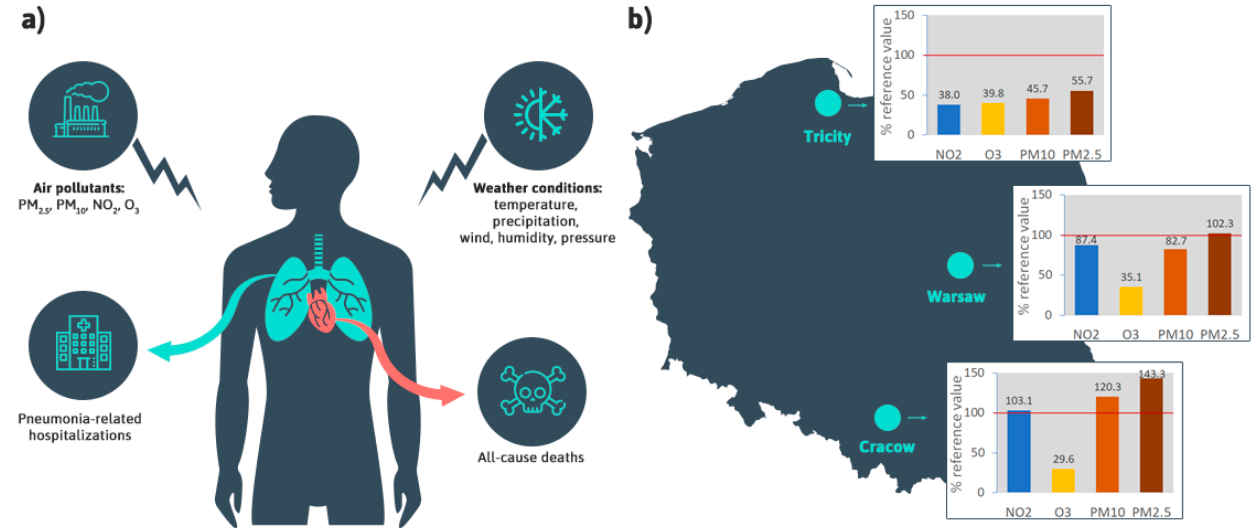
Figure 1. ( a ) The cause and effect relationship between the exposure to air pollution and associated weather conditions and health outcomes, including pneumonia-related hospitalizations and all- cause deaths; ( b ) geographical location of agglomerations: Tricity, Warsaw, and Cracow with mean concentrations of air pollutants in 2011–2018, expressed as a percentage of the reference values (cal- endar year limit values of 40 μ g/m 3 for PM 10 and NO 2 , 25 μ g/m 3 for PM 2.5 , and maximum daily eight- hour mean target value of 120 μ g/m 3 for O 3 were applied according to air quality standards stated in the EU Ambient Air Quality Directive), red lines correspond to 100% [13].